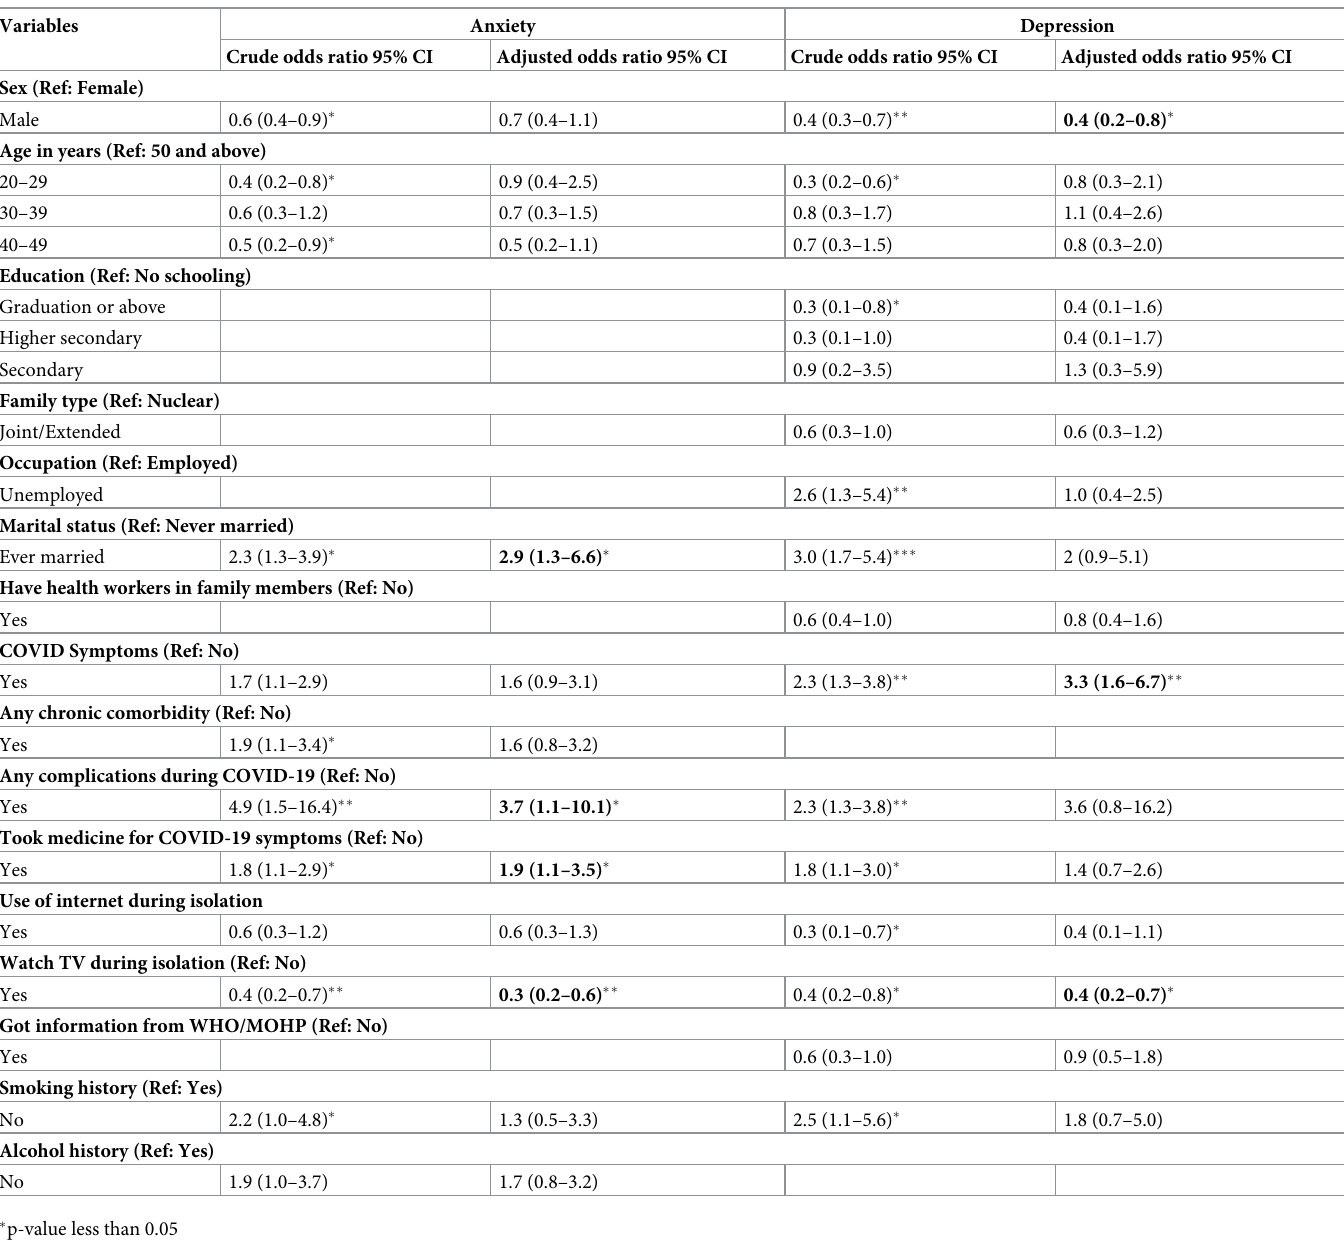
Table 4. Factors associated with anxiety and depressive